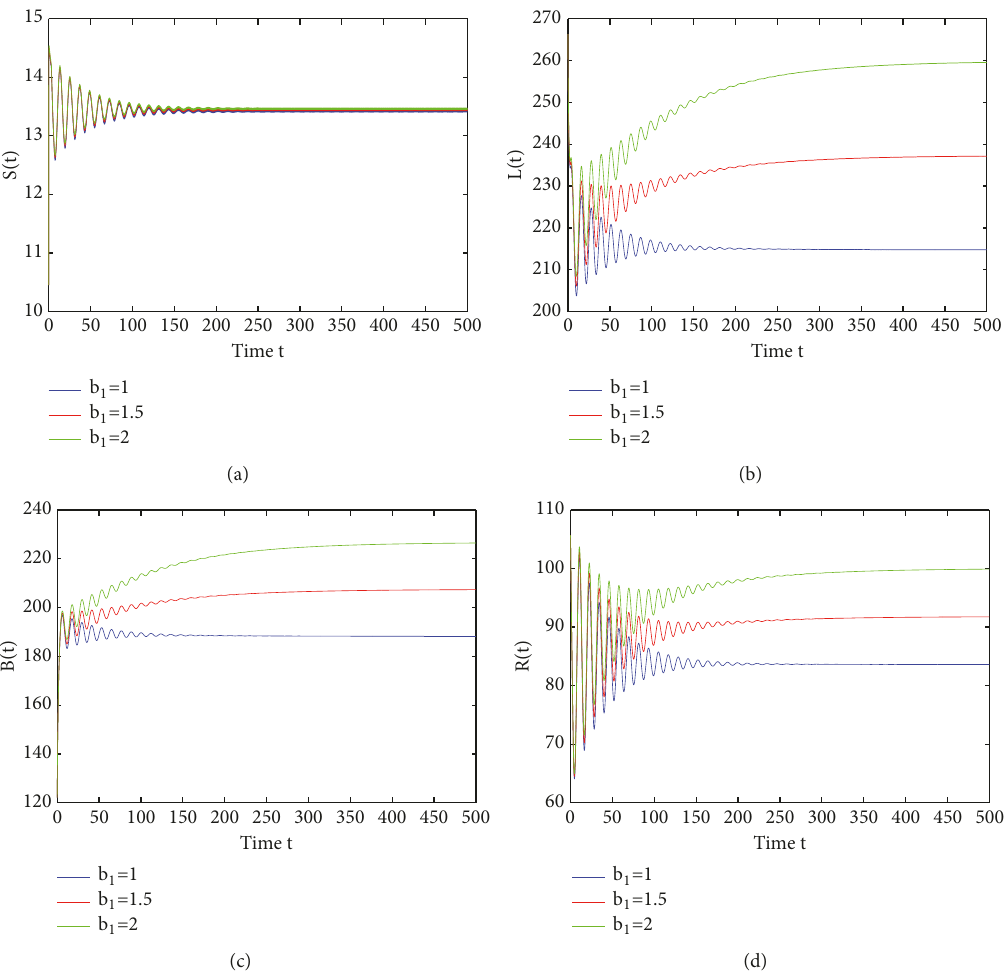
Figure 11: Time plots of 𝑆 , 𝐿 , 𝐵 , and 𝑅 for different 𝑏 1 at 𝜏 = 3.2575 . Rest of the parameters are taken as given in the